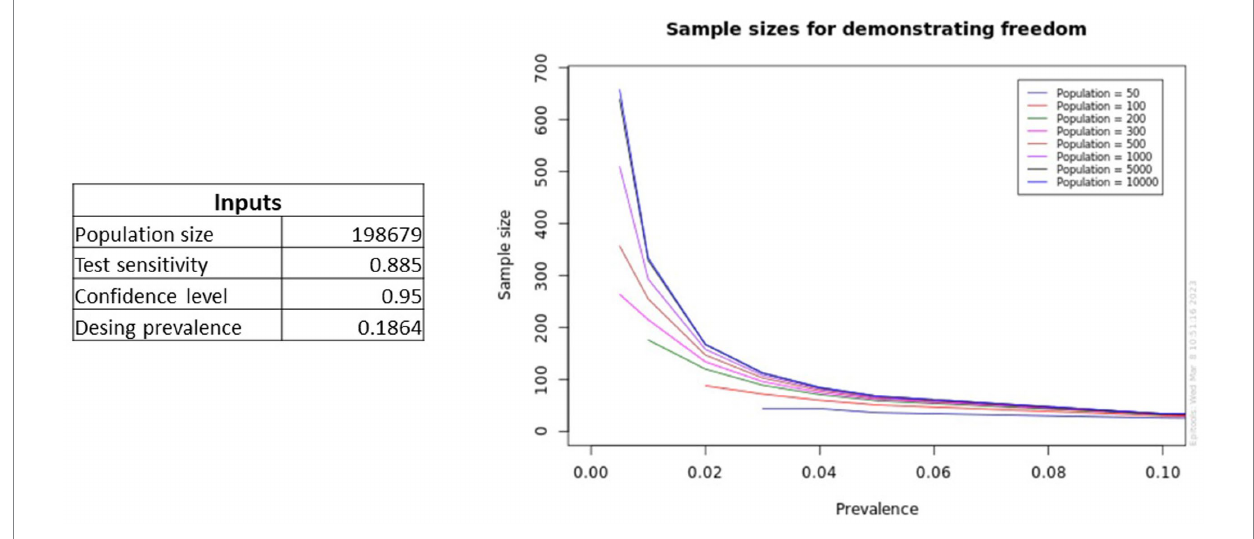
FIGURE 5 Plots generated by the EpiTools calculator showing predictions for different prevalence levels and population sizes for a specified test